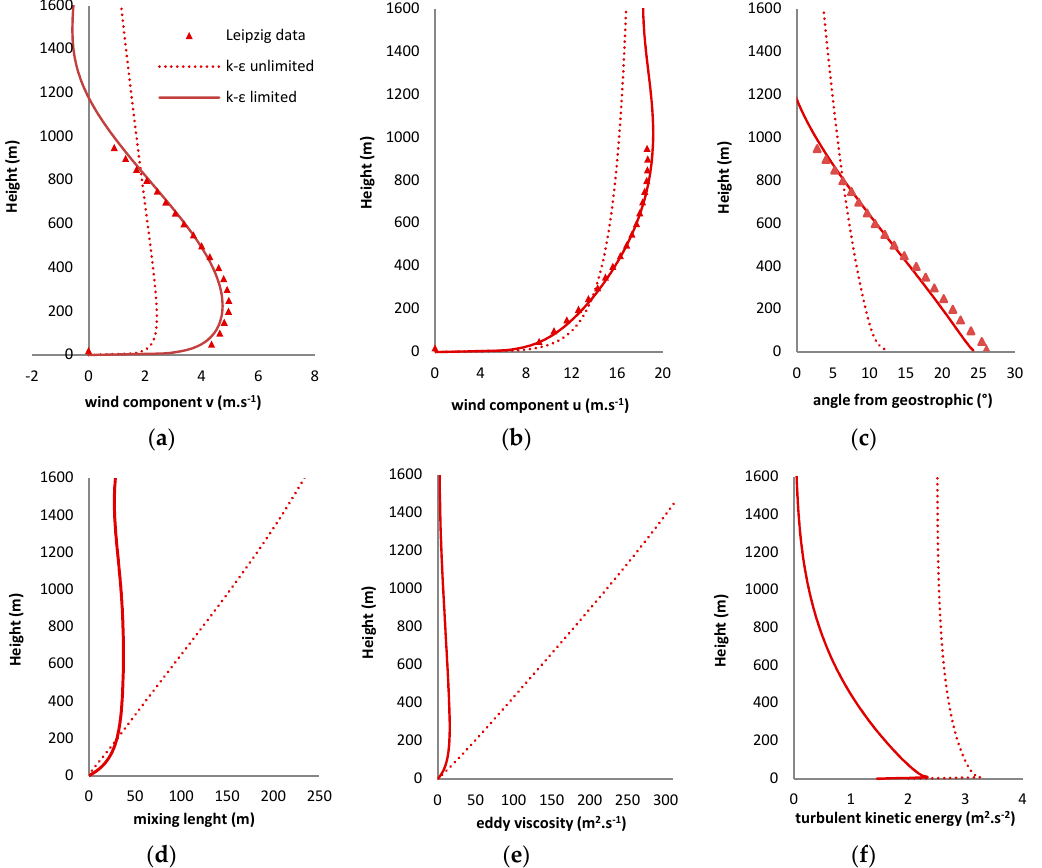
Figure 2. Vertical profile of the wind velocity component 𝑢 ( a ), wind velocity component 𝑣 ( b ), tuning of wind ( c ), mixing length ( d ), eddy viscosity ( e ) and turbulent kinetic energy ( f ).